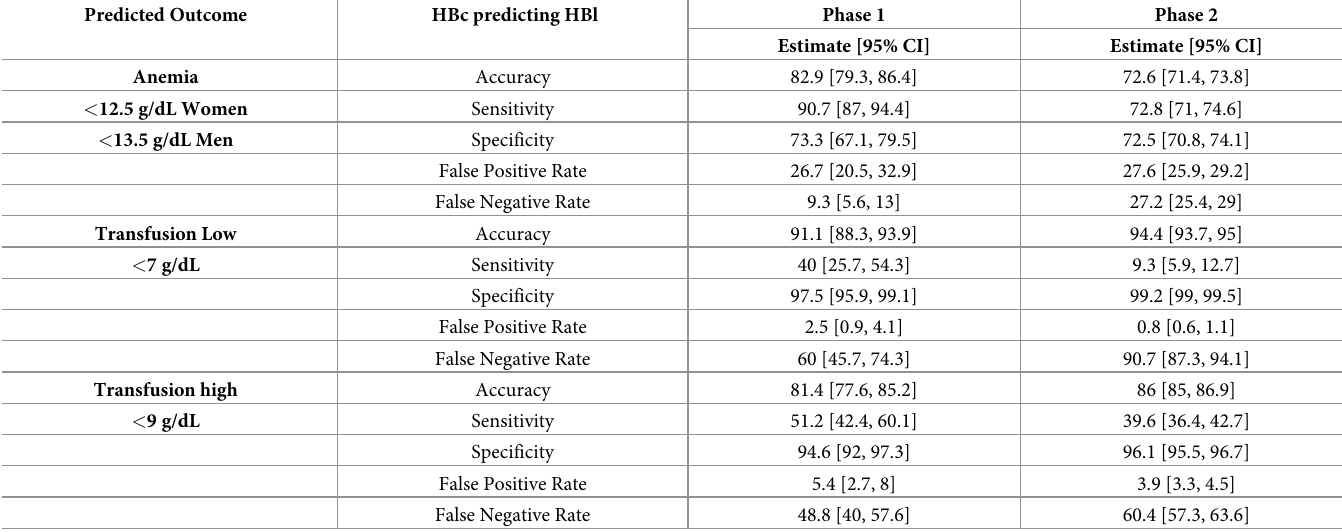
Table 1. Clinical usefulness of conjunctiva determined HB determined from derivation (Phase 1) and validation (Phase 2) data sets. Predicted Outcome